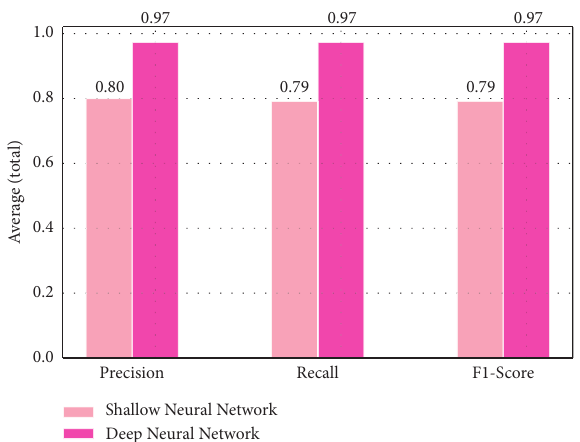
Figure 5: Comparison of Precision, Recall, and F1-Score in Neural Network models.